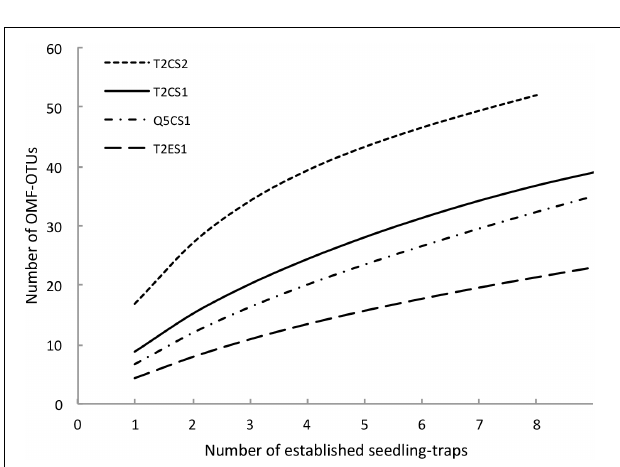
FIGURE 3 | Frequency distribution of the identified fungal orders of the orchid mycorrhizal fungi identified in association with Cyrtochilum retusum and Epidendrum macrum .